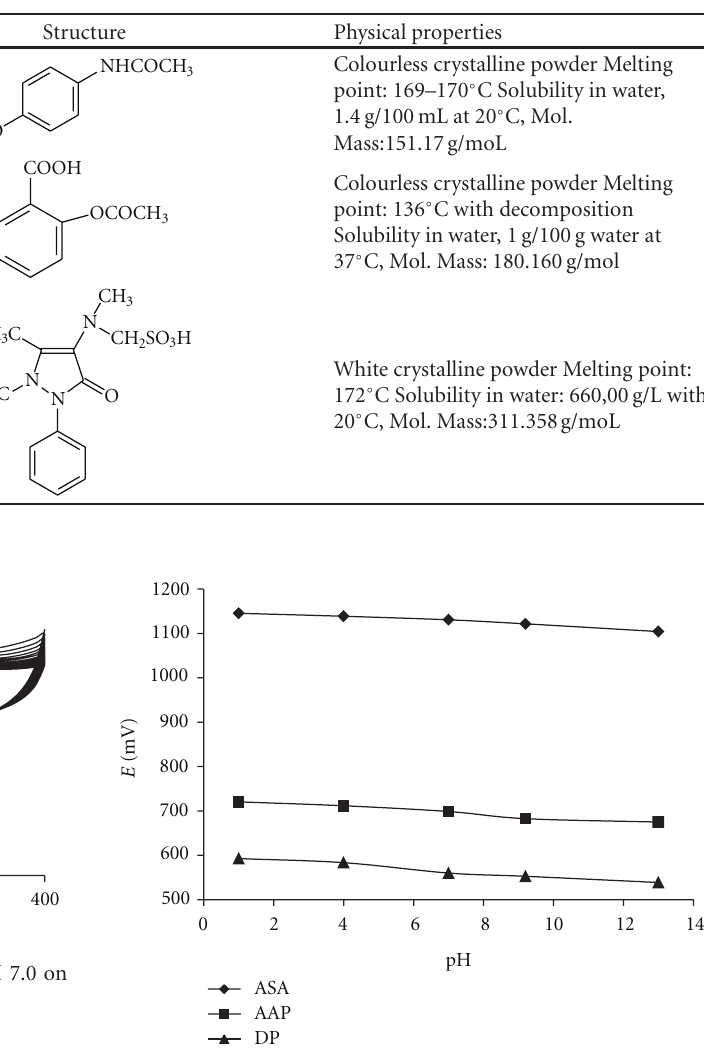
Table 1: Structure and physical parameters of drugs.